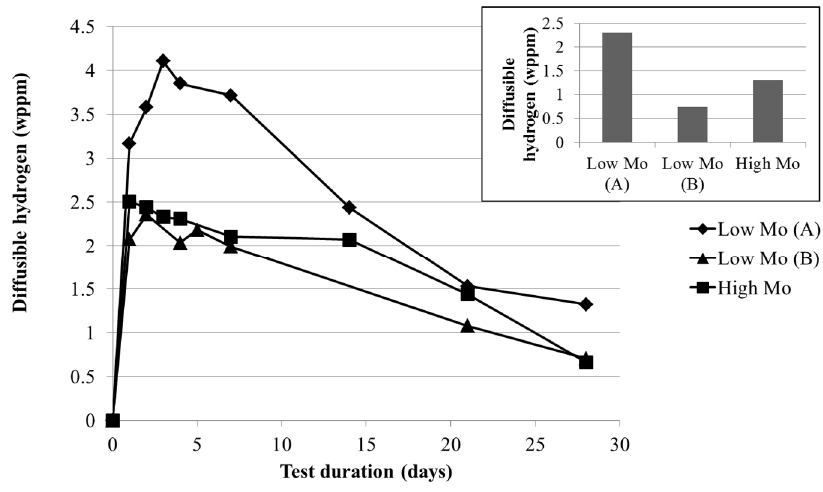
Figure 8. Amount of diffusible hydrogen, determined using a hot extraction technique, present in the low Mo (A), the low Mo (B), and the high Mo material as a function of the test duration and after electrochemical charging (inset).